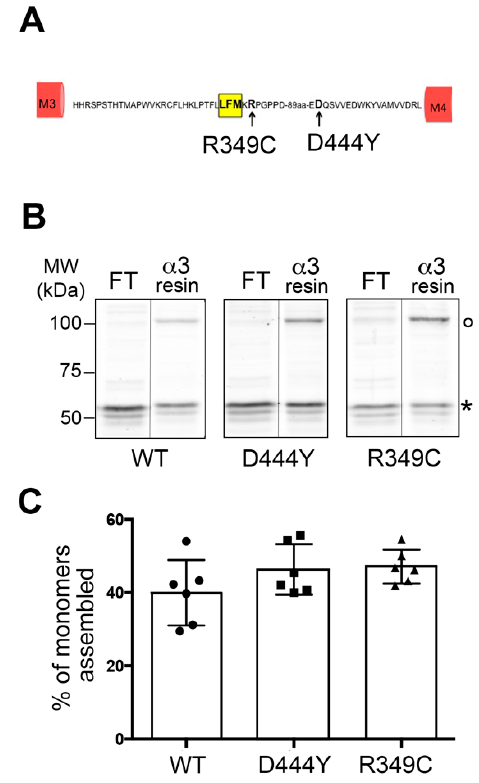
Figure 1. Mammalian cell expression of α 3 β 4 nAChRs with a WT or variant ‐ bearing accessory β 4 subunit. ( A ) Schematic representation of the intracellular loop between TM domains 3 and 4 (M3 and M4, respectively; red boxes) of the human β 4 subunit. The yellow box indicates the LXM export motif, and the arrows indicate the amino acids modified to obtain the R349C and D444Y variants. ( B ) Assembly of pentamers of α 3 β 4 nAChRs with a WT ‐β 4 or variant ‐ bearing β 4 subunit in the fifth position. Lysates of HeLa cells transfected with dimer plus WT ‐β 4 ( ● ), D444Y ‐β 4 ( ◼ ) or R349 ‐β 4( ▲ ) were passed on a resin covalently linked to anti ‐α 3 antibodies. The bound ( α 3 ‐ resin) and unbound (flowthrough, FT) material was run on SDS ‐ PA gels and stained with anti ‐β 4 antibodies. The circle ( ○ ) indicates a band of approximately 110 kDa corresponding to the dimer, and the asterisk (*)indicates a band of approximately 60 kDa corresponding to the β 4 monomer. ( C ) Quantification of the percentage of β 4 monomers bound to α 3 ‐ resin assembled in pentamers. In three separate experiments performed in duplicate, there were no statistically significant differences in the assembly of α 3 β 4 nAChRs with a WT ‐β 4, D444Y ‐β 4 or R349C ‐β 4 subunit in the fifth position (one ‐ way ANOVA, Kruskal–Wallis